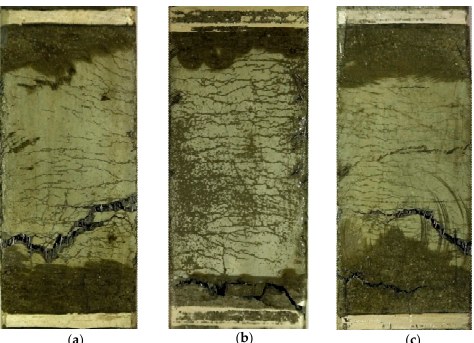
Figure 8. Effects of adding MGFs on the multiple cracking response of HPFRCCs: ( a ) M0.00, ( b ) M0.05, and ( c ) M0.10.